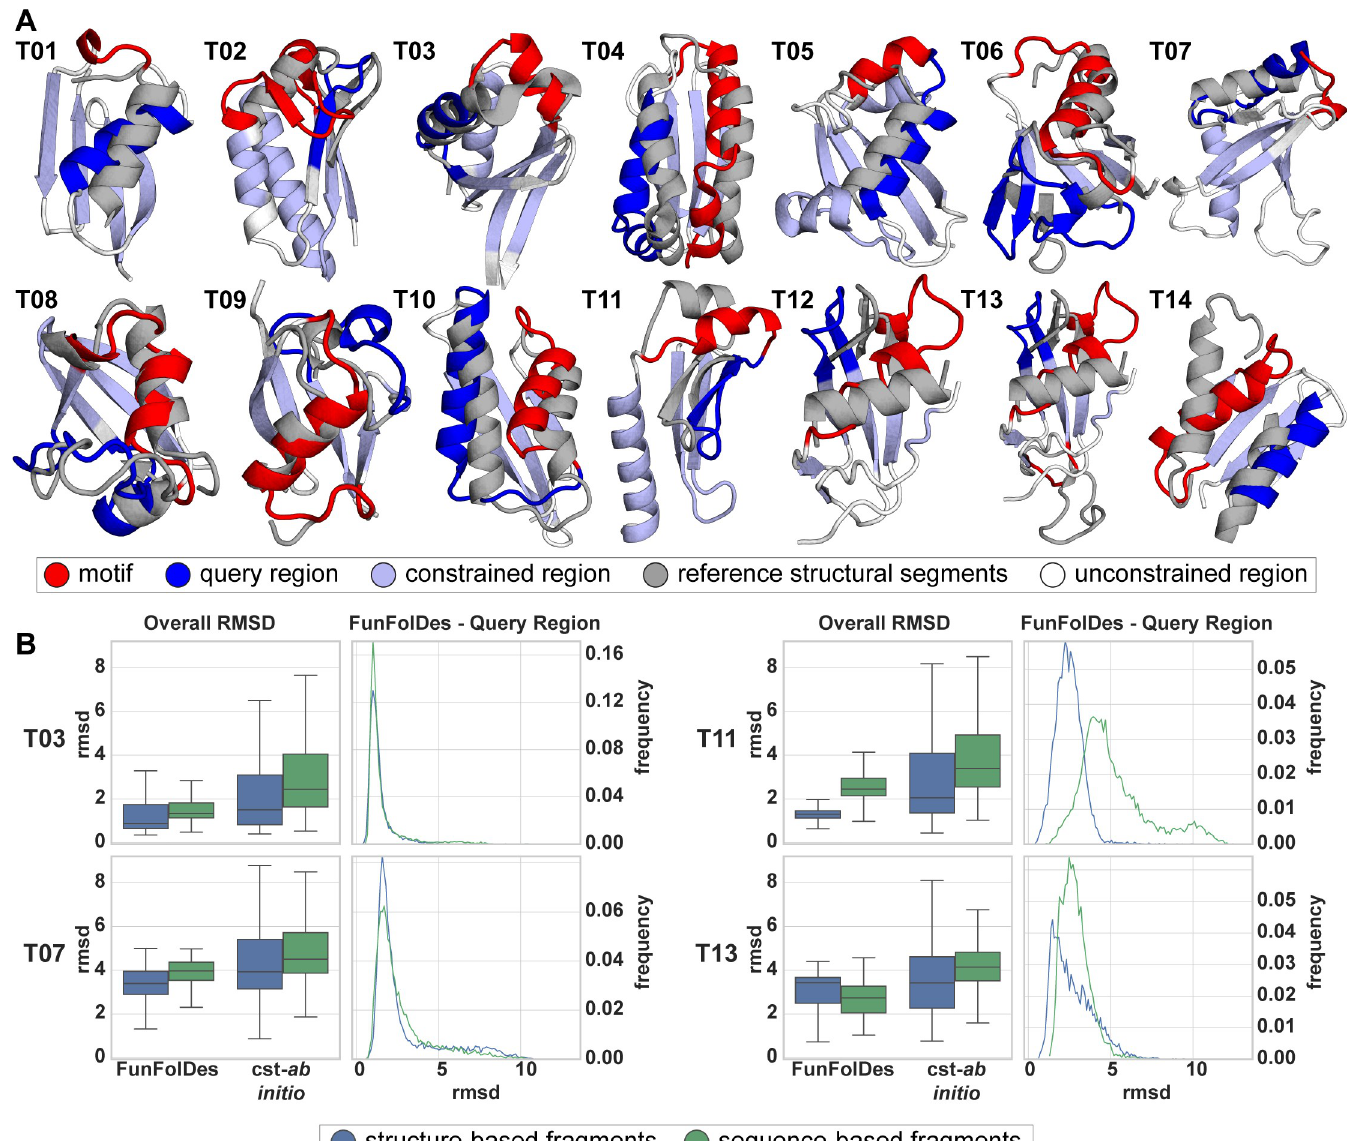
Fig 2. Benchmark test set to evaluate FunFolDes structural sampling. A) Structural representation of the 14 targets used in the benchmark. In each target is highlighted the motif (red) and query (blue) regions, and the positions from which distance constraints were generated (light blue). Conformations of the motif and query regions, as found in the template structures, are shown superimposed in light grey. B) Full structure RMSD (Overall RMSD) and local RMSD for the query region (FunFolDes–Query Region) is presented for four targets (full dataset presented in S1 Fig ). Overall RMSD compares results for the two simulation modes (FunFolDes Vs. constrained– ab initio (cst-ab initio )) and the two fragment generation methods (structure (blue) Vs. sequence-based fragments (green)) against their original target. FunFolDes more frequently samples RMSDs closer to the conformation of the target structure. Generally, structure-based fragments contribute to lower mean overall RMSDs. The FunFolDes–Query Region RMSD distributions show that the two fragment sets do not have a major importance in the structural recovery of the query region.